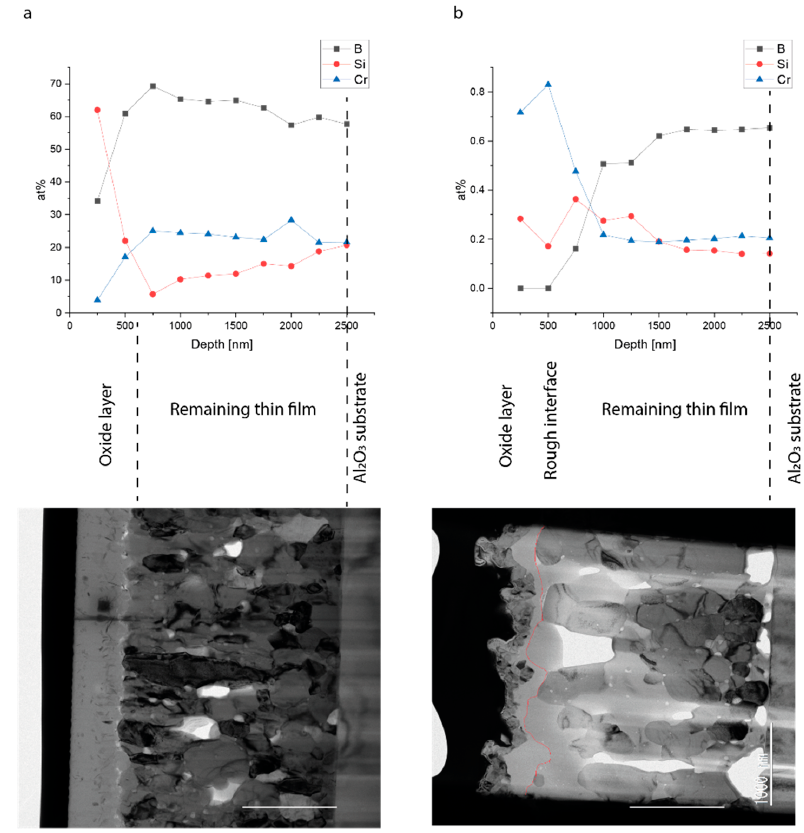
Figure 4. LASIL depth profiles with corresponding bright-field TEM cross-sections of the samples: ( a ) sample A (native stoichiometry Cr 0 . 27 Si 0 . 9 B 0 . 64 ); ( b ) sample B (native stoichiometry Cr 0 . 26 Si 0 . 16 B 0 . 58 ). The scale bar represents 1000 nm, and the images were rotated to correspond to the depth profiles. The thin red line in the TEM image of sample B indicates the boundary of the oxide and was determined with high-angle annular dark-field imaging (HAAFD) STEM (scanning transition electron microscopy).